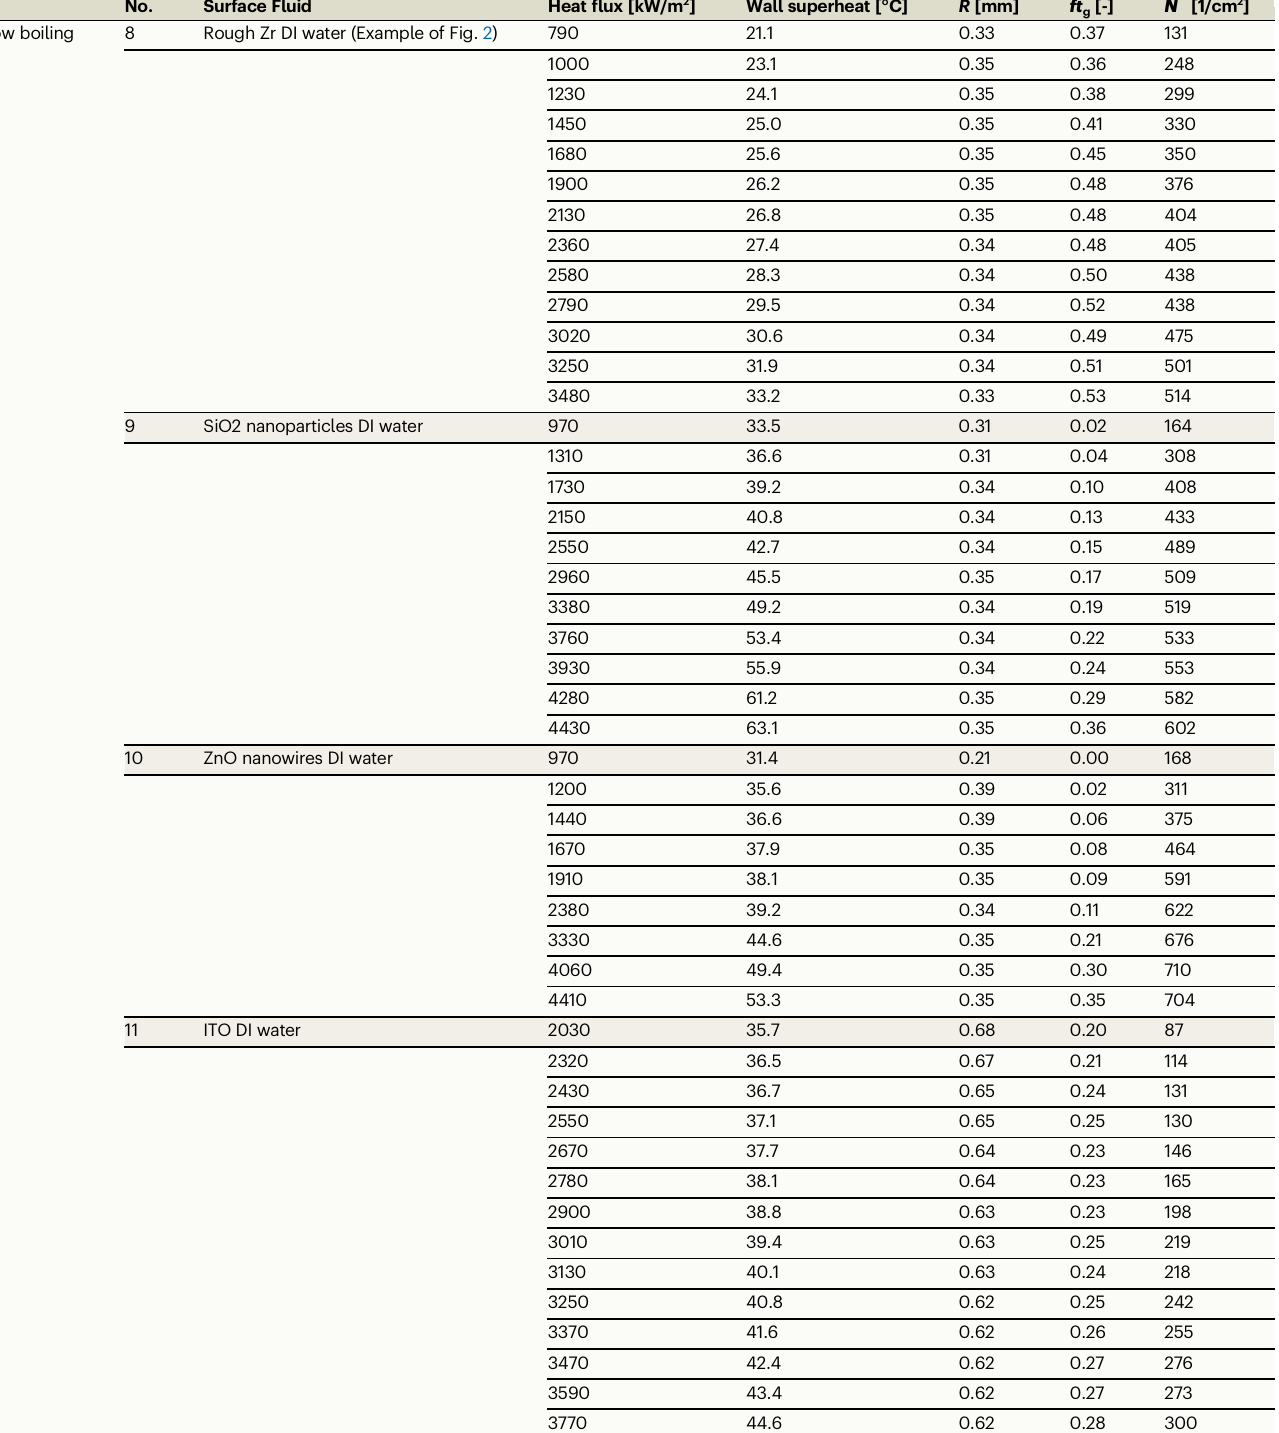
Table 2 | Data of heat fl ux, wall superheat, average bubble footprint radius, R , product of bubble growth time and departure frequency, ft , and nucleation site density, N 00 , for all surfaces and operating conditions tested in fl ow boiling g No. Surface Fluid Rough Zr DI water (Example of Fig.